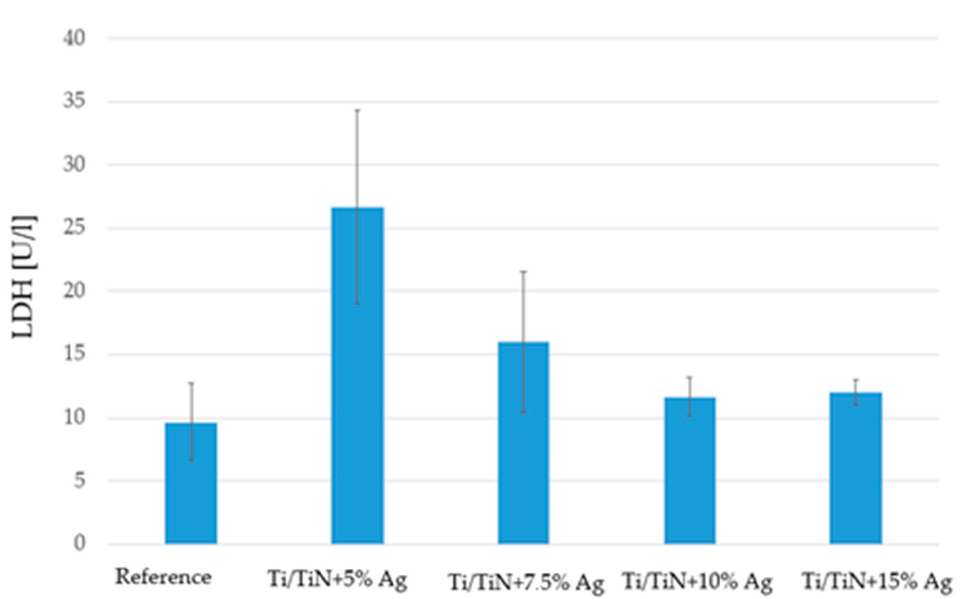
Figure 4. Results of cytotoxicity tests using lactate dehydrogenase ( n = 5 ± SD).